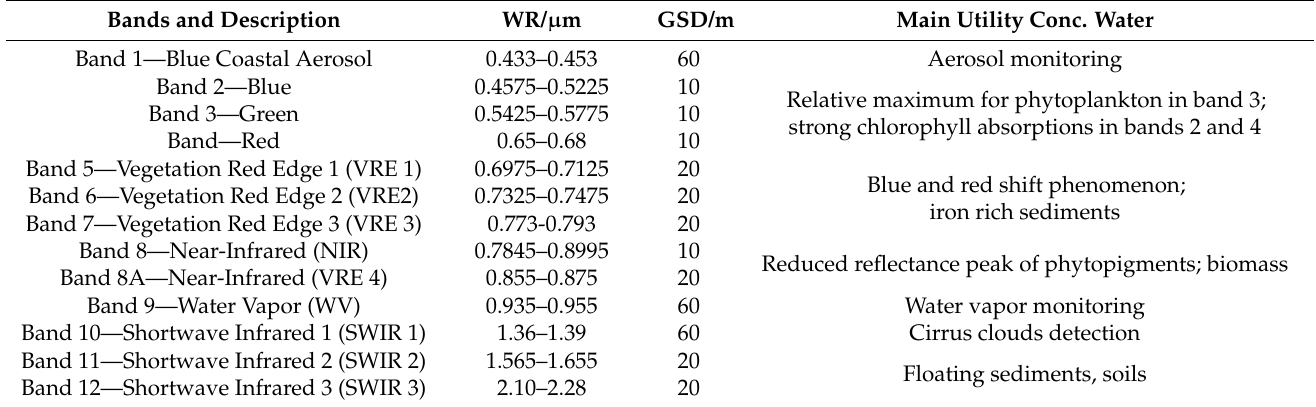
Table 2. Parameter information of Sentinel-2A/B data. WR = wavelength range, GSD = original spatial